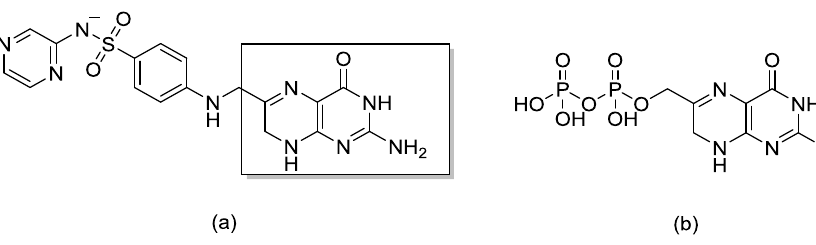
Figure 5. Structures of ( a ) the hypothetic product of compound 4a and ( b ) 6-hydroxymethyl-7,8- dihydropterin diphosphate (HMDPdiP) used for the docking experiments. Fragment of HMDPdiP in the condensed product is in the rectangle.